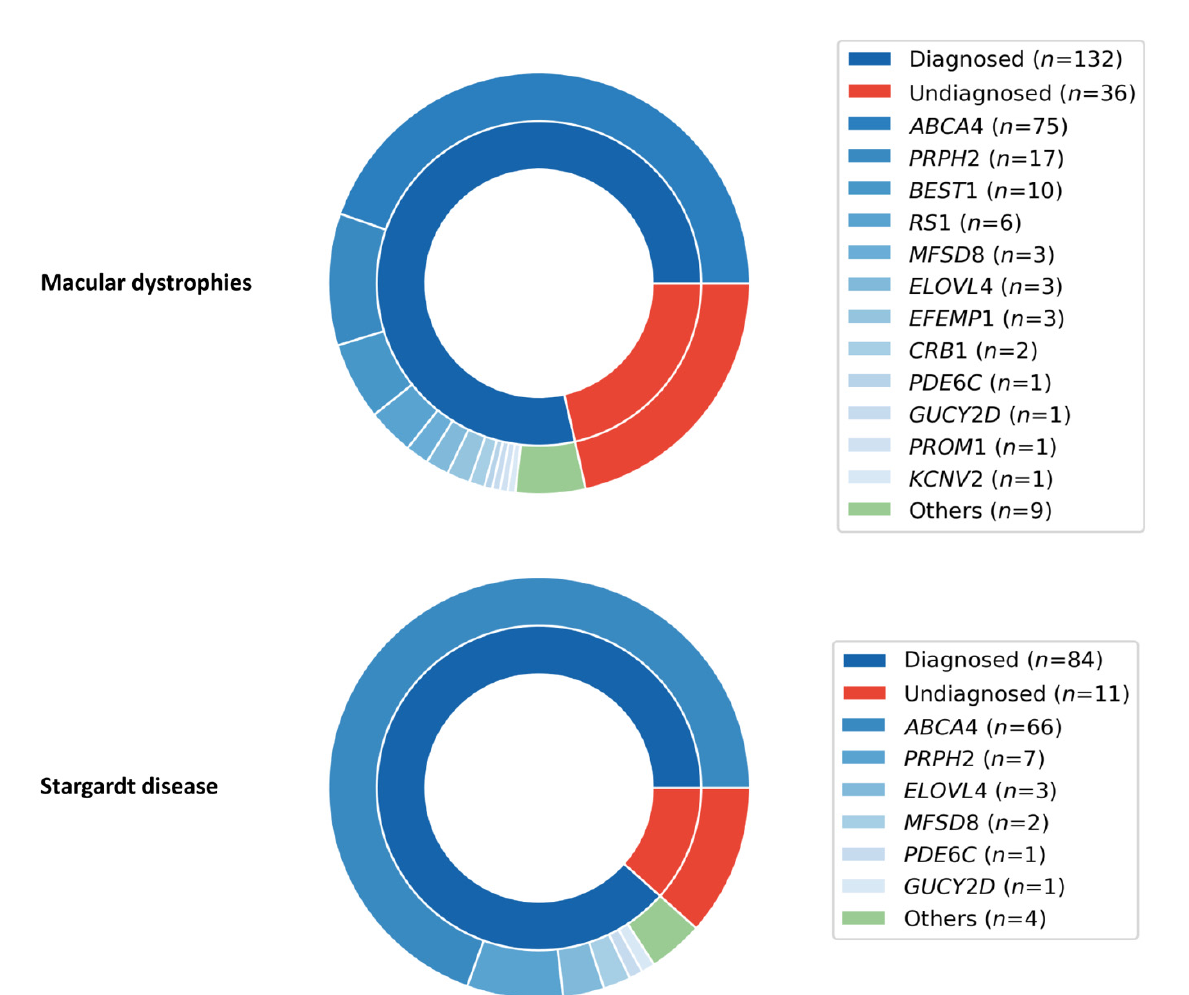
Figure 3. Diagnostic yields and main contributing loci for the macular dystrophies cohort and for the Stargardt disease